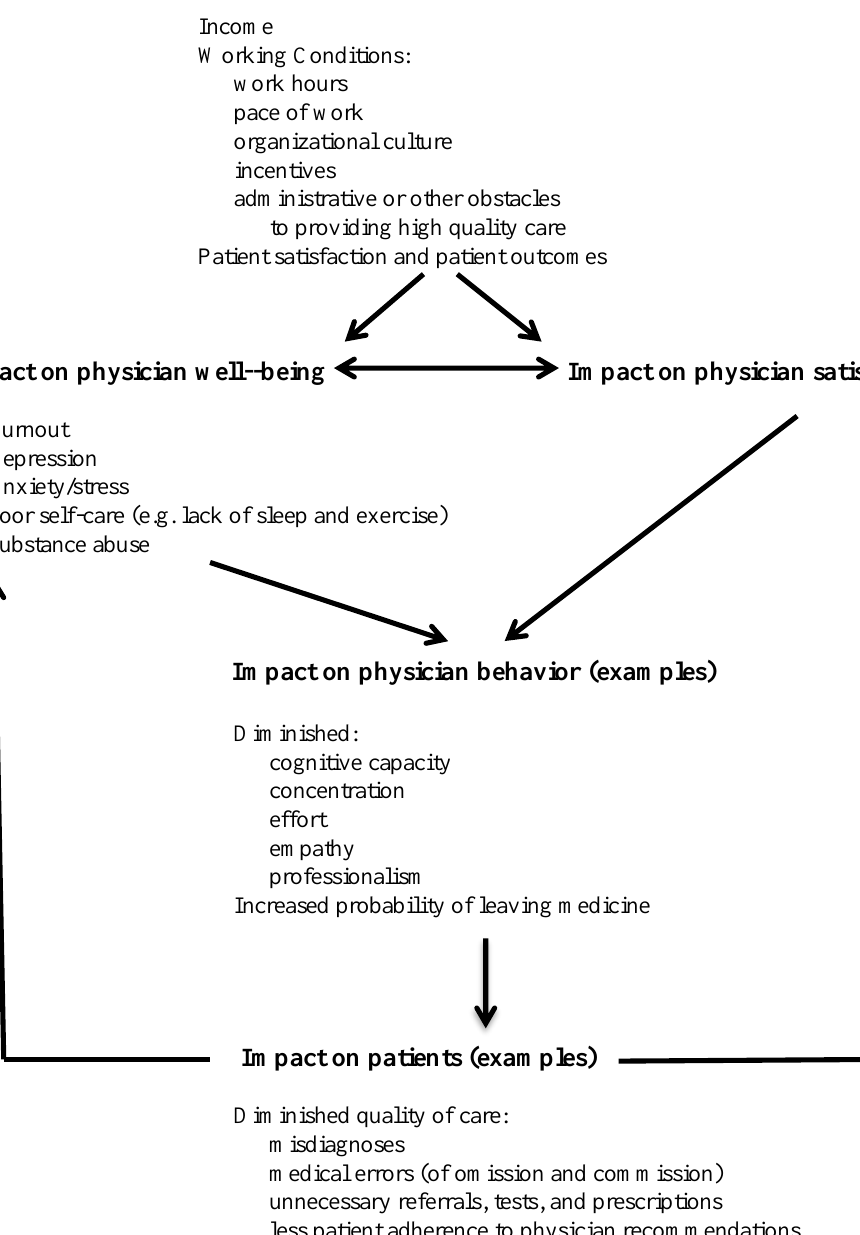
Figure 1 Model of the potential impacts of physician dissatistfaction Factors that affect physician well-being and satisfaction